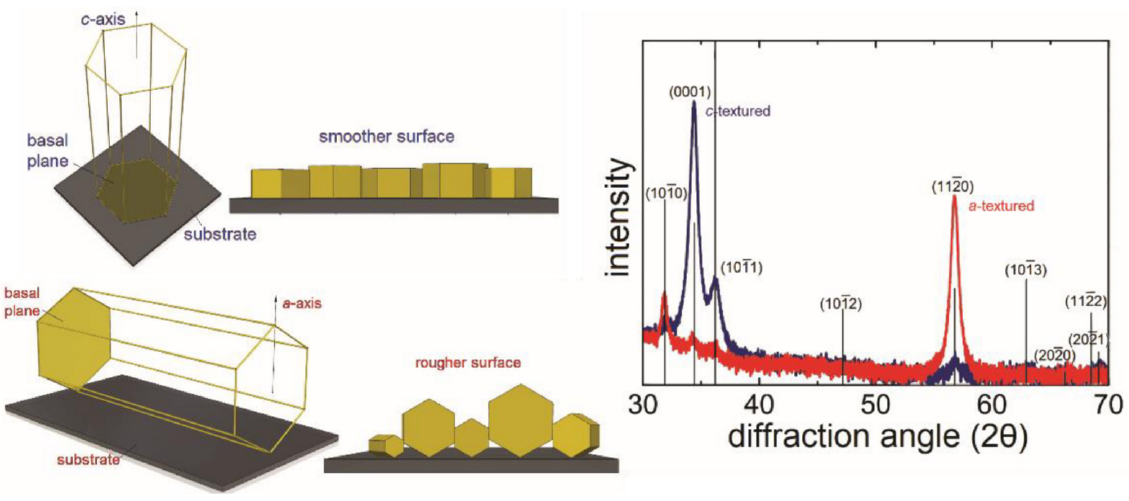
Figure 2. Schematic representation of the geometrical configurations and their corresponding X-ray diffraction patterns of c - and a -textured ZnO films. Adapted with permission from ref. [27]. Copyright Year 2014